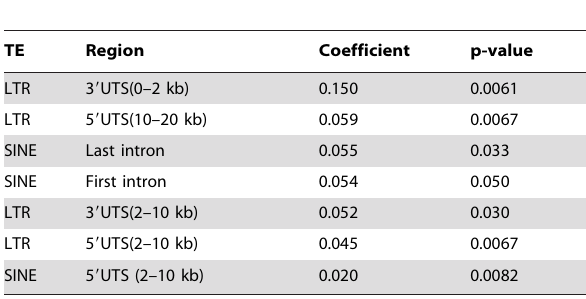
Table 2. The regression coefficients from a stepwise multiple regression of ED against